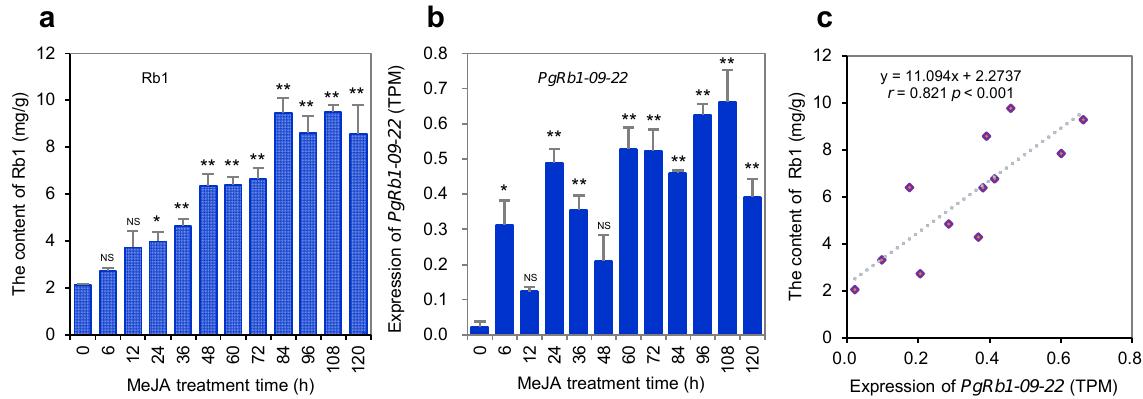
Figure 4. The 22 PgRb1 candidate genes in the adventitious roots treated with MeJA for 6 h through 120 h, relative to the control roots not treated with MeJA (0 h). ( a ) Rb1 content variation in the adventitious roots treated with MeJA, relative to the control root. ( b ) The expression variation of one representative of the 22 PgRb1 candidate